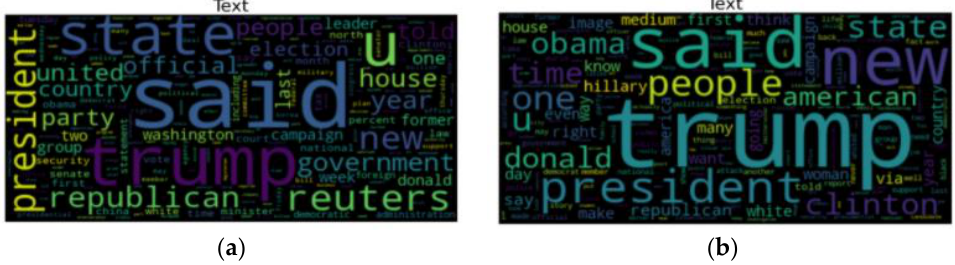
Figure 4. Word cloud of text from real and fake news; ( a )word cloud representing the frequently occurring words in the real news dataset; ( b ) Word cloud representing the frequently occurring words in the text of the fake news dataset.